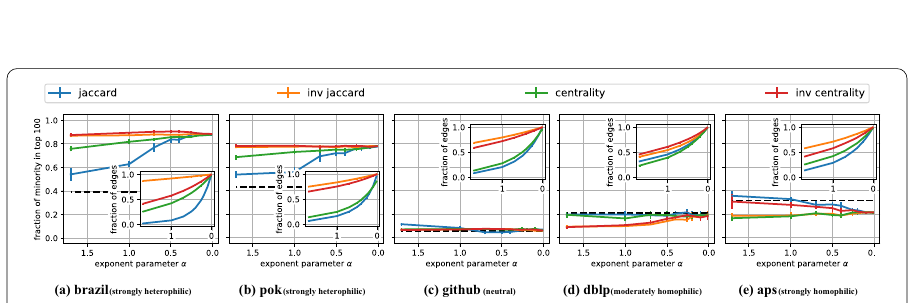
Fig. 6 Effect of structure-based noise on real data sets. In analogy to Fig. 4 we show the impact of structure-based noise. We see that in the heterophilic regime the effects of noise are similar to those in synthetic networks. In the homophilic regime different effects can be observed. For instance, for dblp removing edges within the strong community structure with inverse Jaccard noise leads to a disadvantage of the minority. Overall we can see that structure-based noise can also significantly affect real world networks. This effect can sometimes be even more prominent or different than in synthetic BA